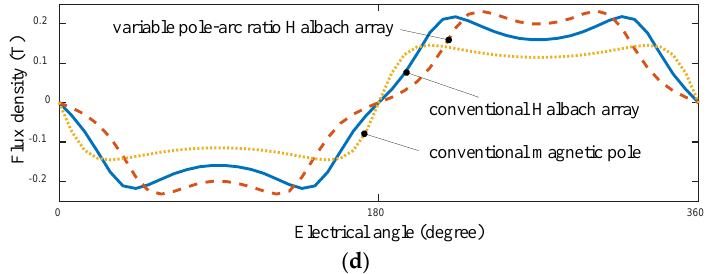
Figure 6. Flux intensity in the air-gap, calculated with quasi-3-D: ( a–c ) Comparison between the quasi-3-D and the 2-D finite-element method (FEM) for the conventional magnetic pole, the conventional Halbach array, and VPAR-DHA, respectively; ( d ) Flux intensity at the middle slice.